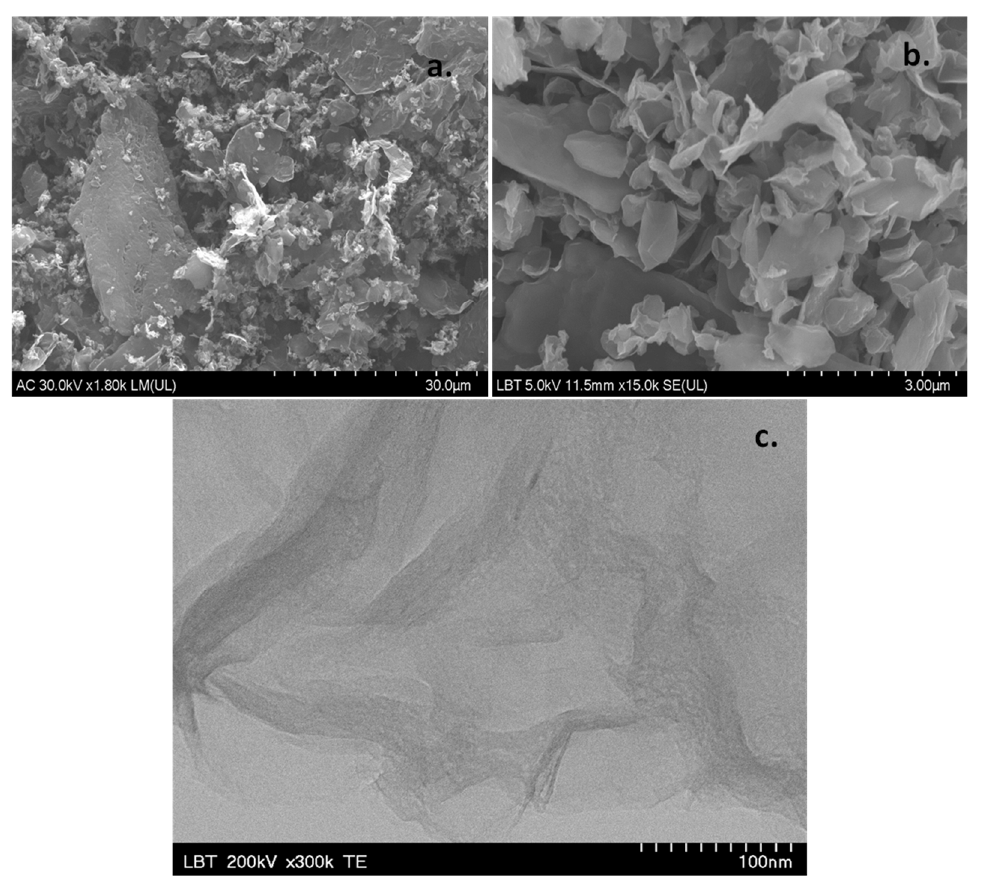
Figure 1. Representative SEM ( a , b ) and TEM ( c ) micrographs of the EGr sample; scale bar 30 µm ( a ); 3 µm ( b ); and 100 nm ( c ).